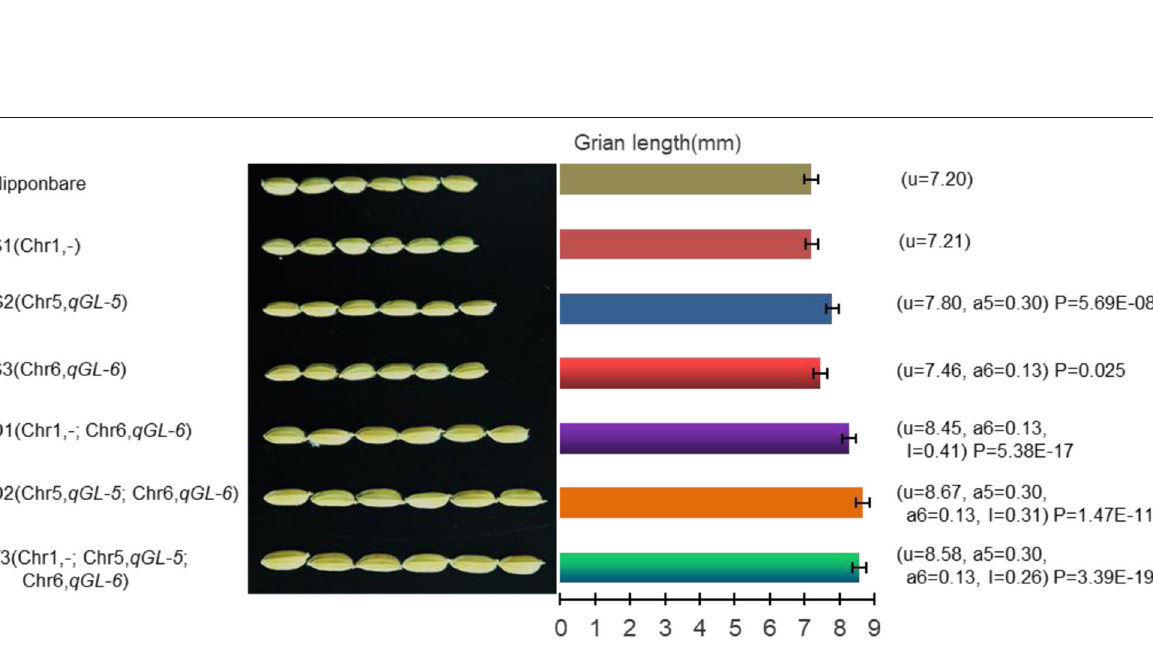
Fig. 6 Phenotype and genotype analysis of six chromosome segment substitution lines. u is the phenotypic value; a denotes the additive effect; I denotes the epistatic effect. A t -test was used to analyse significant